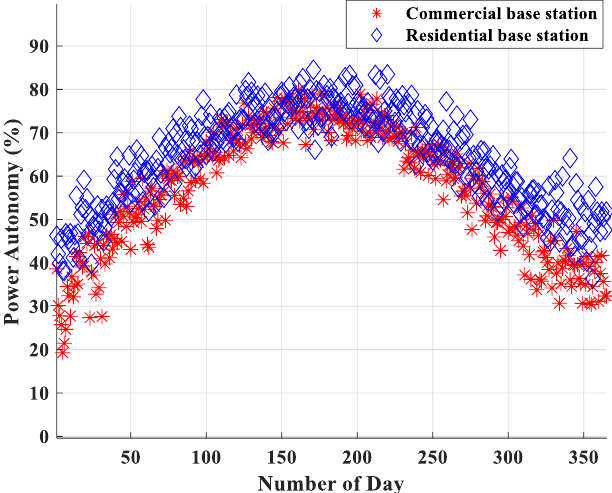
Figure 16. Power autonomy factor for Aalborg throughout the year.